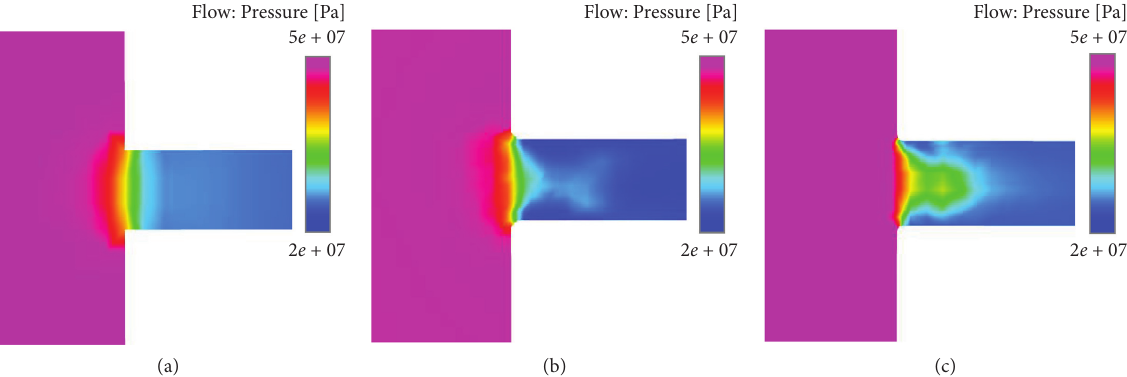
Figure 23: Pressure distribution near damping hole under stable condition. (a) Without chamfer. (b) 45-degree chamfer. (c) Arc chamfer.